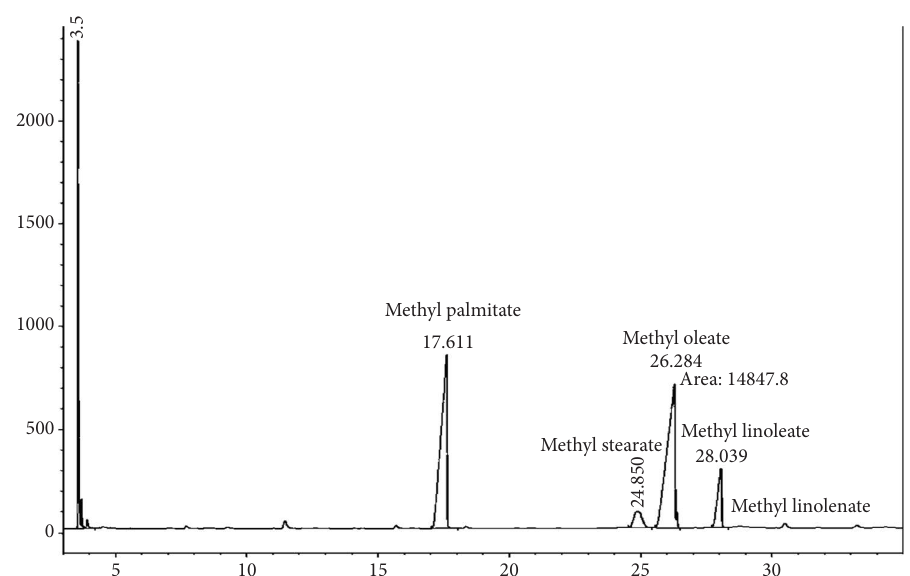
Figure 2: FAME profle of the produced